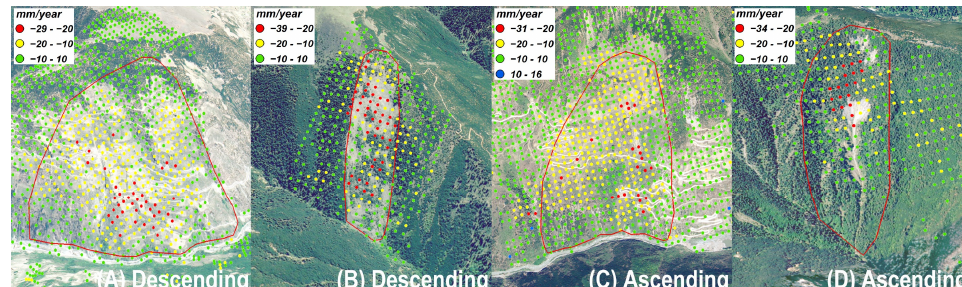
Figure 5. Typical landslide deformation maps and optical images. The optical images (about 2-meter resolution) were obtained from the Google Earth platform. (The legend is the same as Figure 4.)